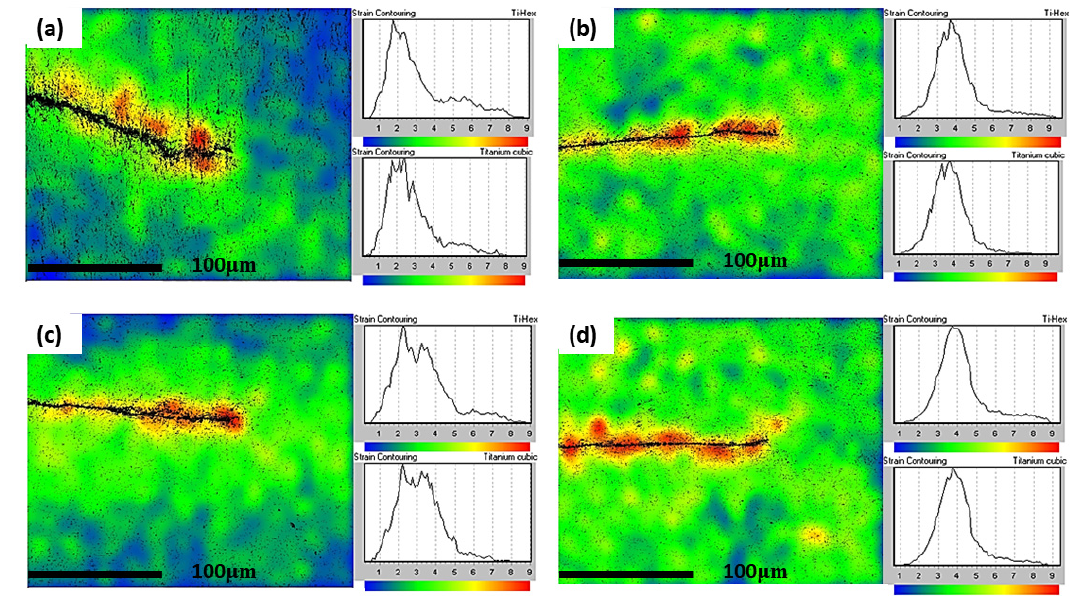
Figure 14. Strain contouring maps ( a ) IP 200 − 500 °C ( b ) OP 200 − 500 °C ( c ) IP 200 − 550 °C ( d ) OP 200 − 550 °C .